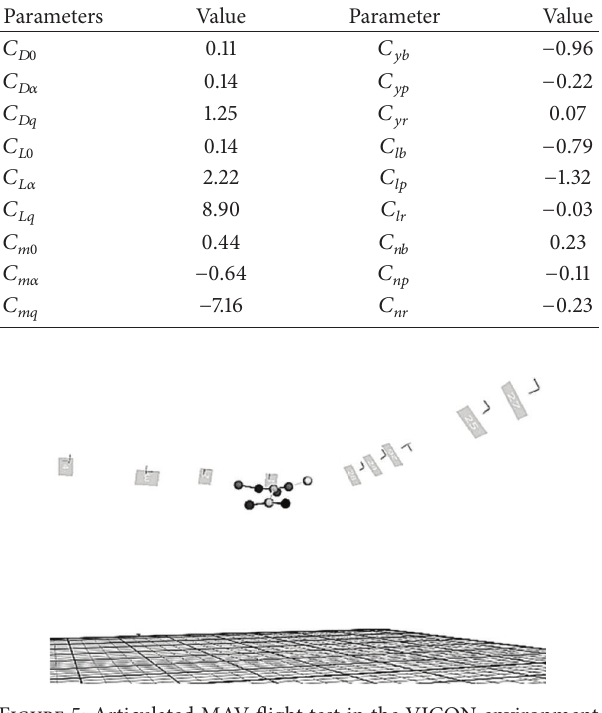
Figure 5: Articulated MAV flight test in the VICON environment showing individual reflective marker positions.